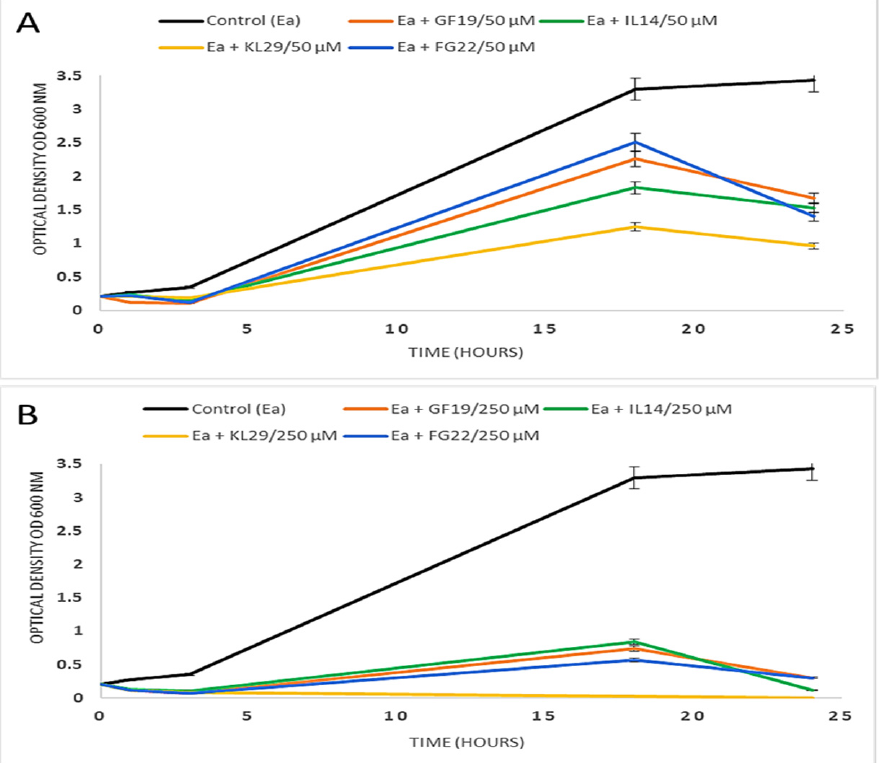
Figure 1. Optical density graphs showing the growth of Erwinia amylovora -treated antimicrobial peptides at 50 µM ( A ) and 250 µM ( B ). Error bars represent standard deviations of three replicates.